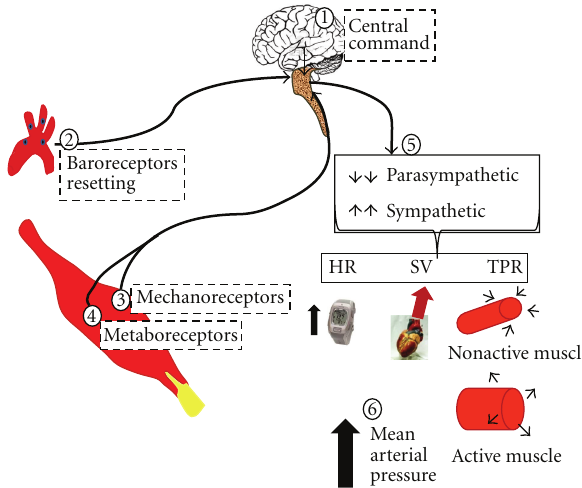
Figure 1: During exercise, neural signals originating from higher cerebral regions (1) and peripheral a ff erents from arterial barore- ceptors (2) and the skeletal muscle (“exercise pressor reflex”, 3 & 4) result in parasympathetic and sympathetic adjustments (5). Consequently, mean arterial pressure rises (6). HR: Heart Rate; SV: Stroke Volume; TPR: Total Peripheral